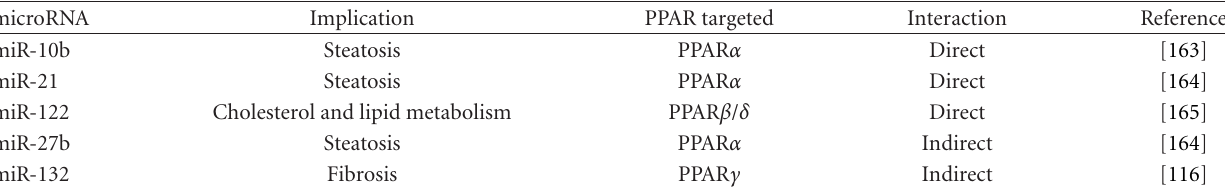
Table 2: miRNAs reported to regulate PPAR γ , PPAR α , and PPAR β / δ expression and activity in the liver. microRNA